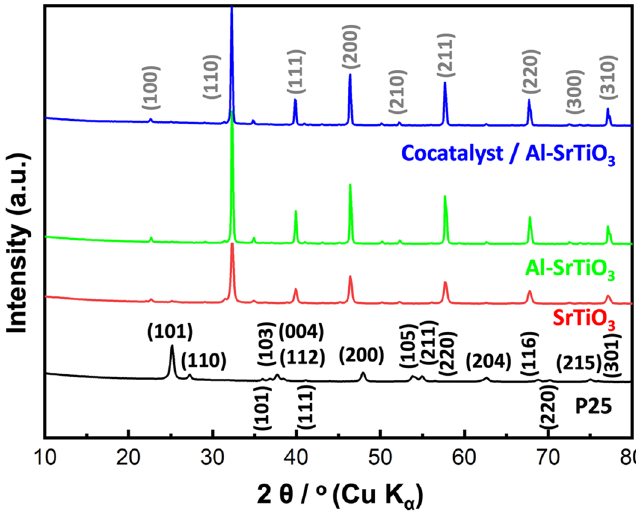
Figure 1. XRD analysis of the investigated